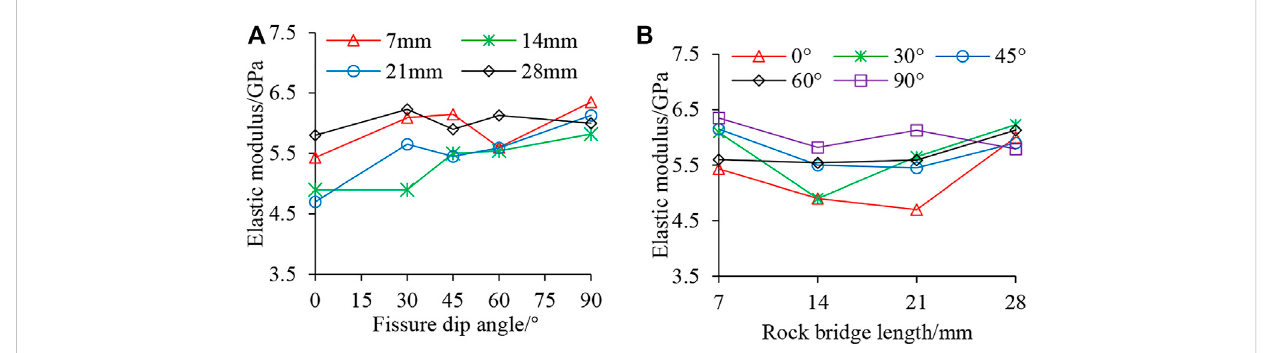
FIGURE 7 The variation of elasticity modulus with fi ssured angles and rock bridge lengths. (A) Fissure dip angle VS. Elastic modulus; (B) Rock bridge length VS. Elastic modulus.